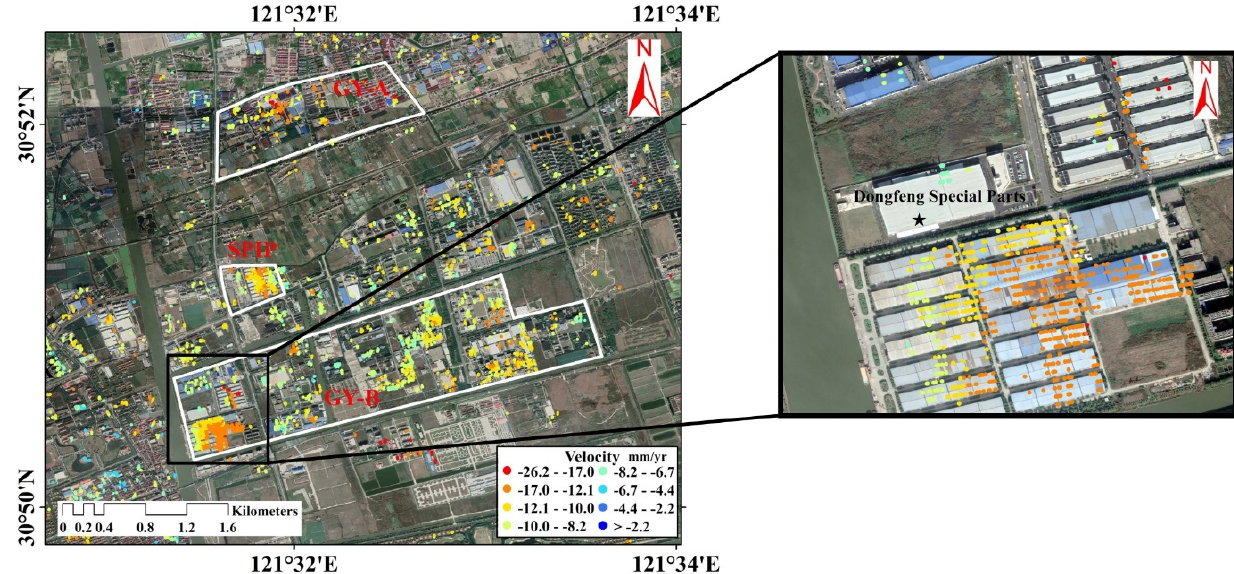
Figure 13. Characteristic area shape rate chart.